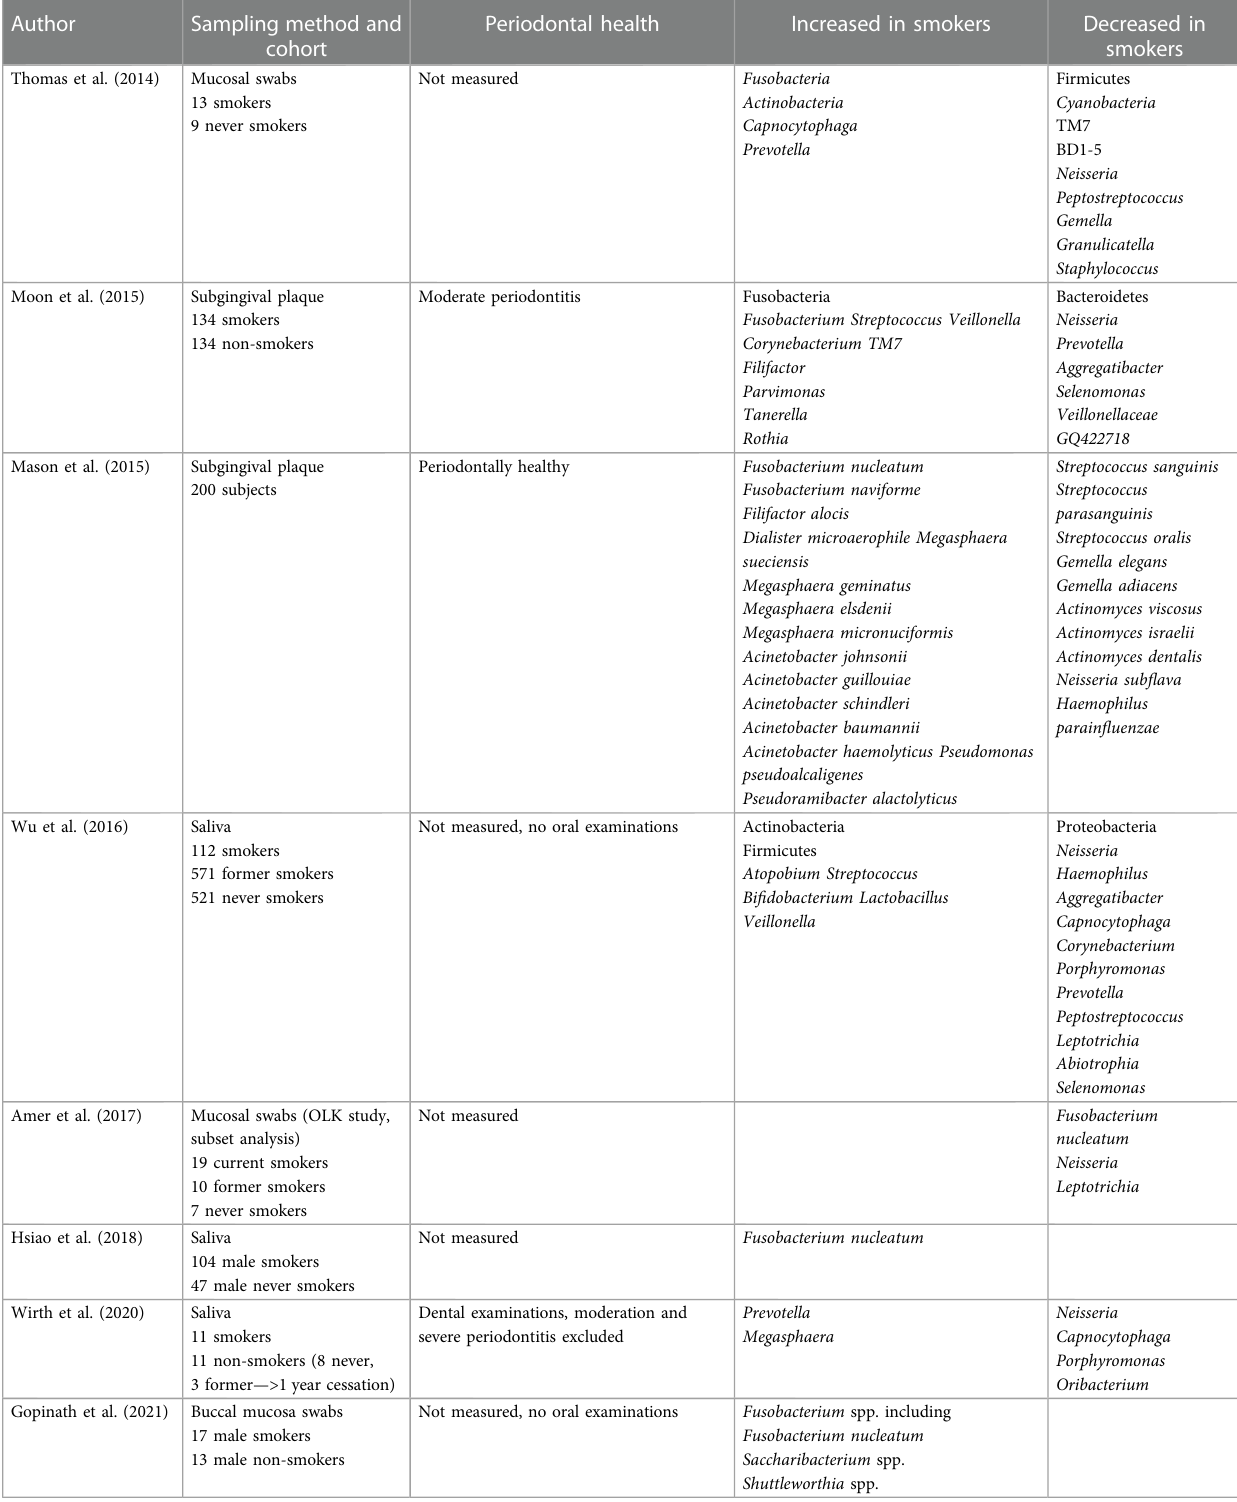
TABLE 1 Signi fi cant differences between the oral microbiomes of smokers and non-smokers in the